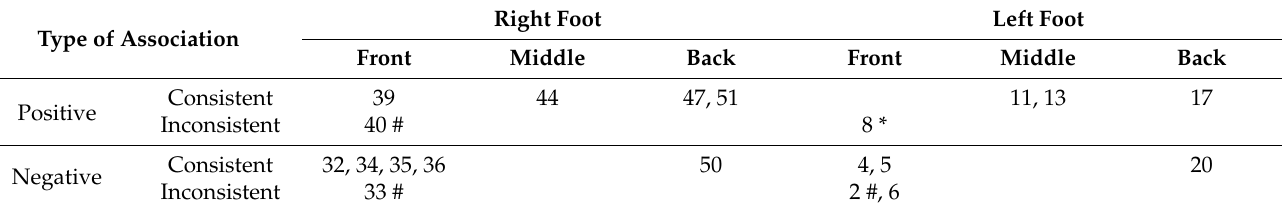
Table 7. Comparison of sensor positions for Modules IIIa and IIIb.